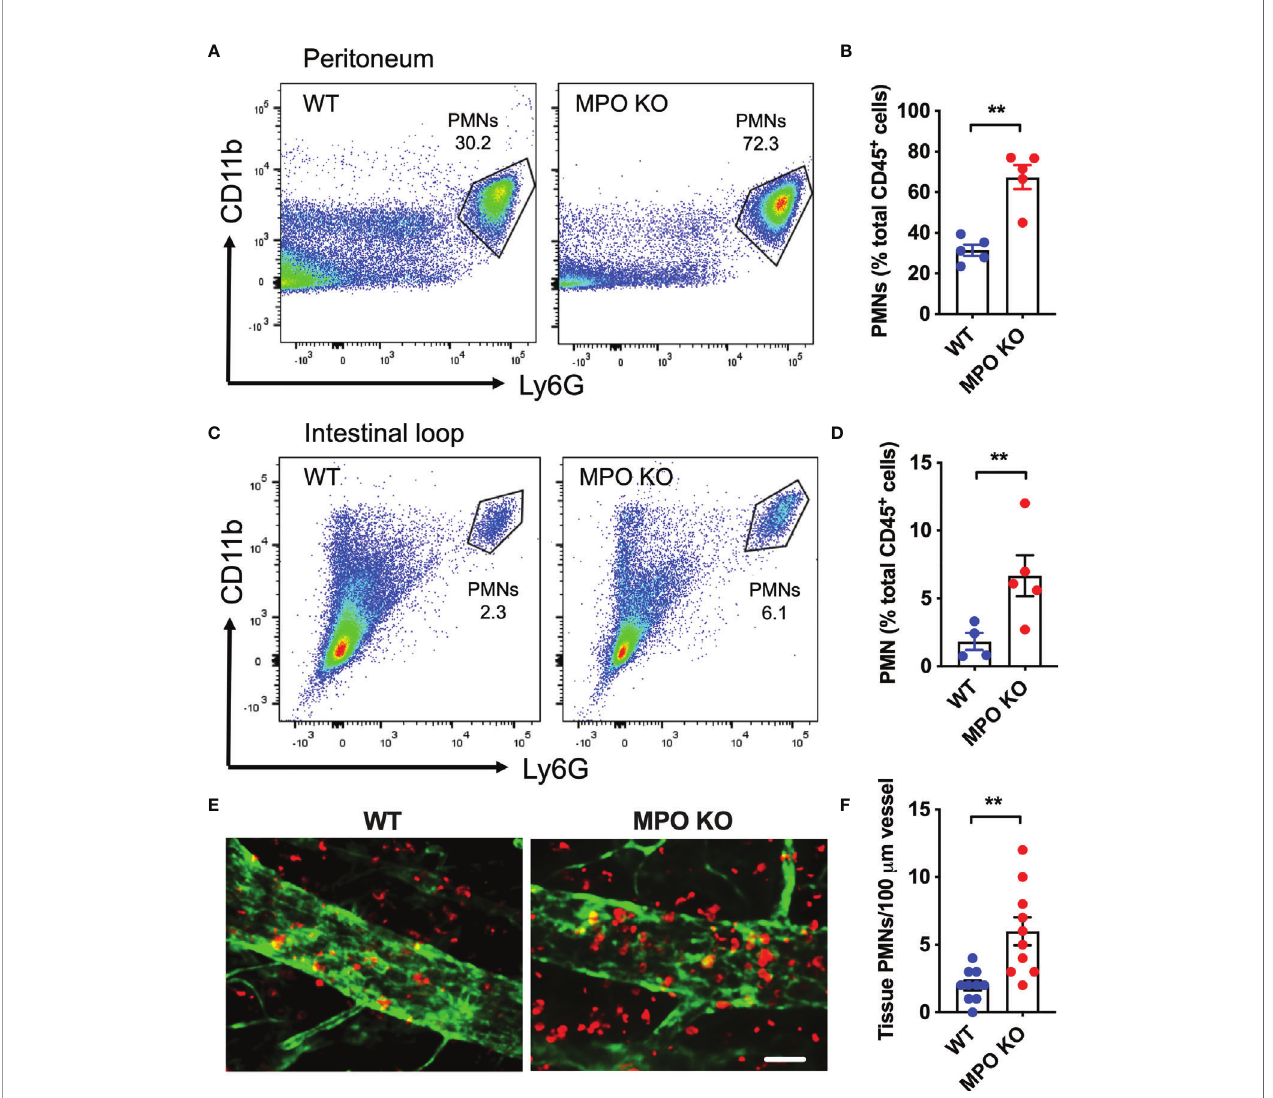
FIGURE 3 | MPO KO PMNs exhibit elevated migratory ef fi ciency. Two in vivo PMN models were used to assess the migratory ef fi ciency of WT and MPO KO PMNs. (A, B) Zymosan-induced peritonitis model was used. (A) Representative fl ow diagrams of lavaged PMNs that have migrated into the peritoneal cavity and (B) Quanti fi cation demonstrate enhanced PMN migration in the absence of MPO. (C – F) Intestinal loop model, where PMN migration into the lumen of ligated intestinal segments is induced by intraluminal CXCL1 administration was used to assess the impact of MPO on PMN migration. (C) Representative fl ow diagrams of lavaged luminal PMNs and (D) Quanti fi cation revealed consistently increased PMN tissue in fi ltration in MPO knockout mice. (E) Representative fl uorescence images of intestinal whole mount tissue following lavage, stained for PMNs (red, S100A8) and ECs (green, CD31) and (F) Quanti fi cation similarly depict increased PMN in fi ltration in MPO KO mice. The bar is 50µm. N=5-7 mice per condition. **p <